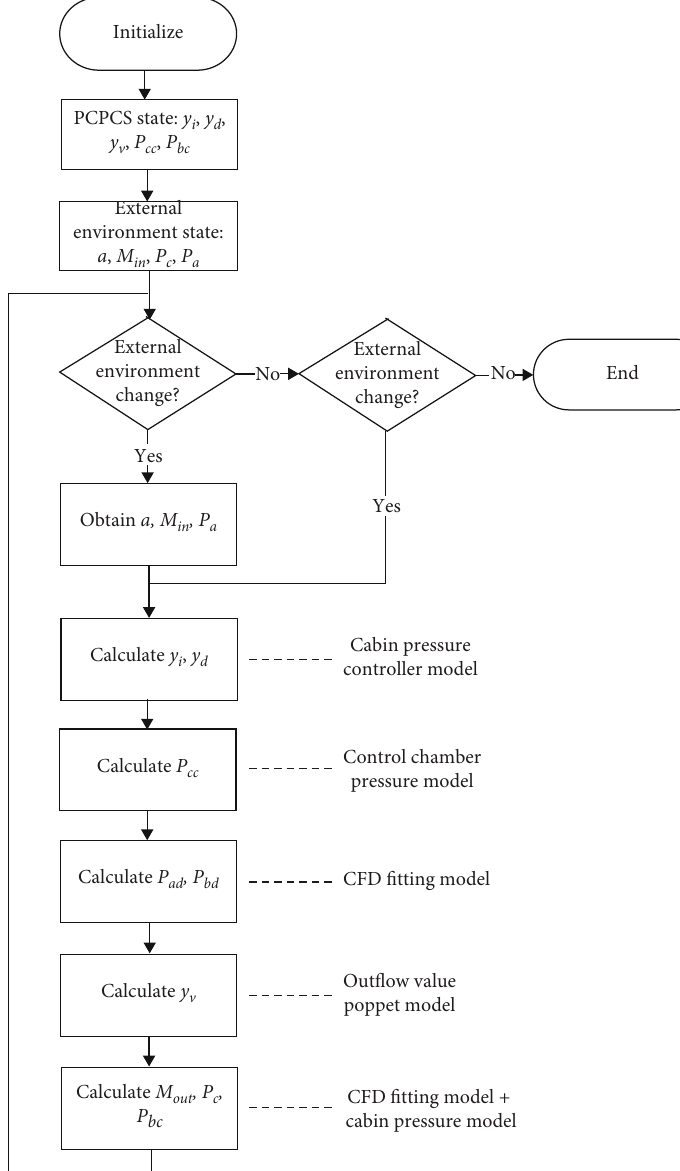
Figure 17: Computing process for PCPCS under maneuvering fl